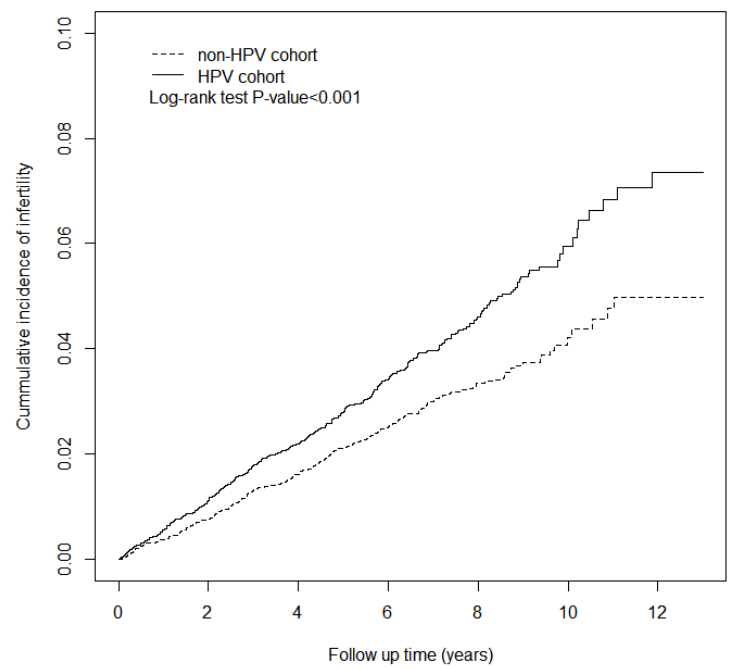
Figure 1. The cumulative incidence of infertility in the human papillomavirus (HPV) cohort and the non-HPV cohort.